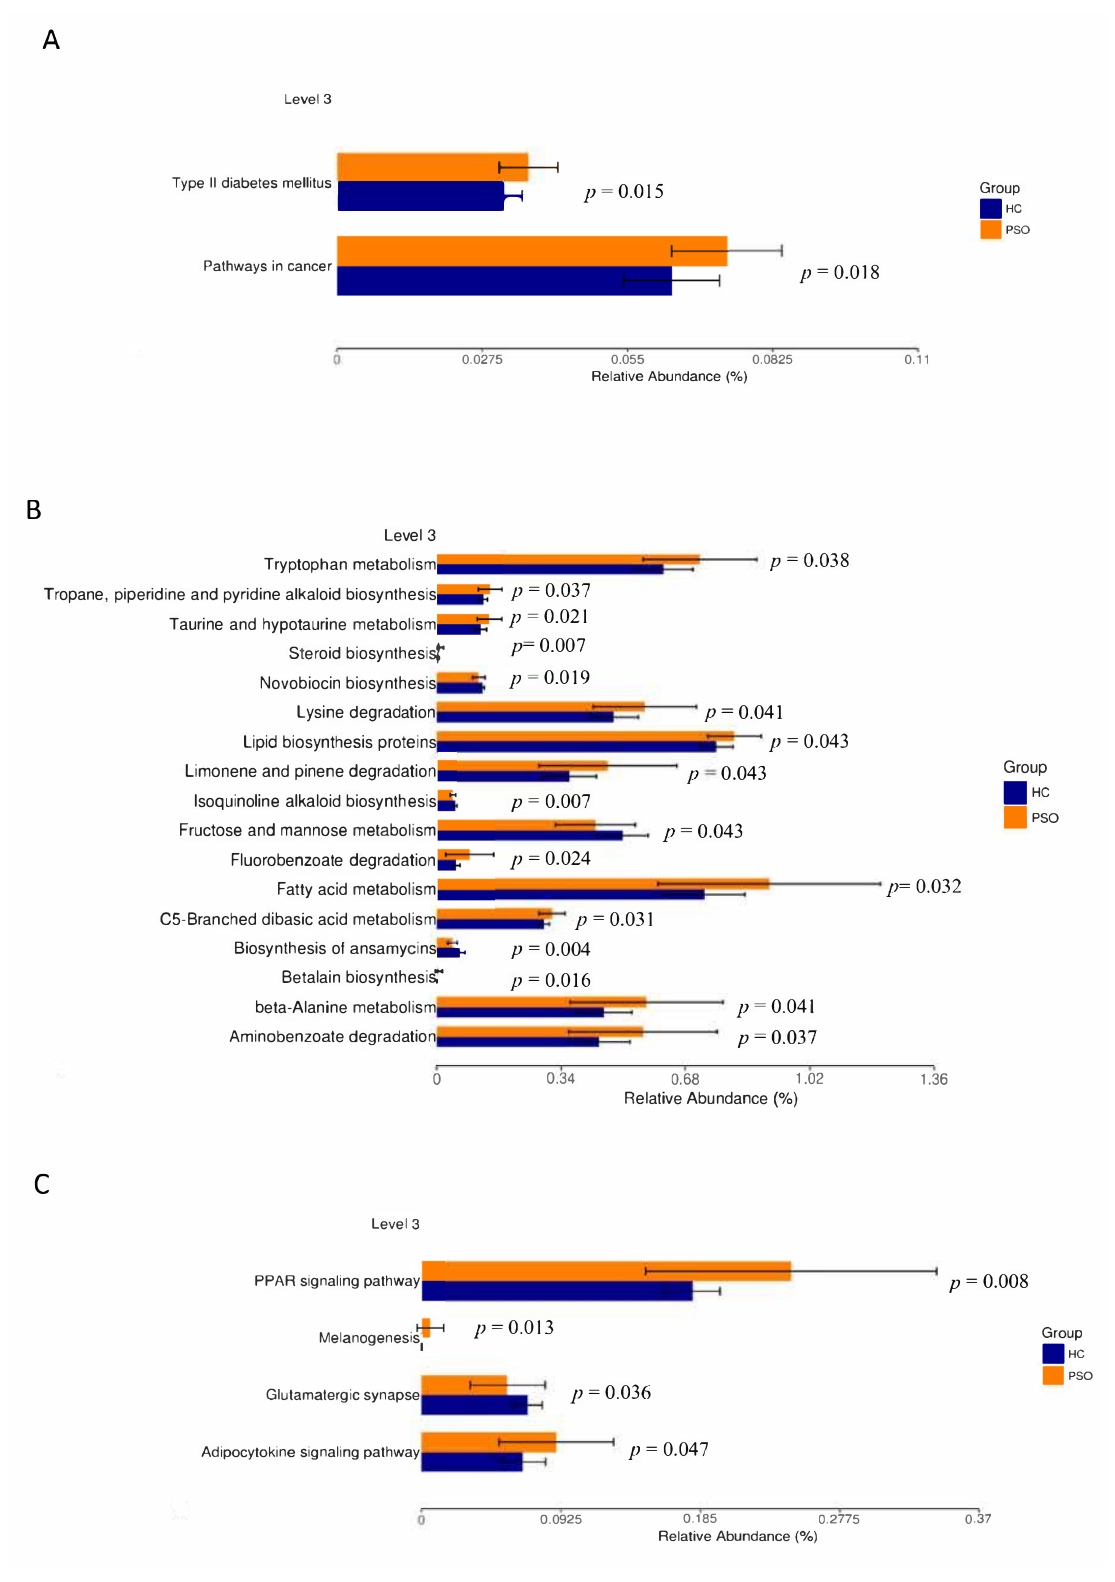
Figure 6. Mean relative abundance of predictive functions at KEGG Level 3 for the two groups. Pathways of human disease ( A ), pathways of metabolism( B ), functional pathway of body system ( C ) (HC: healthy control group; PSO: psoriasis